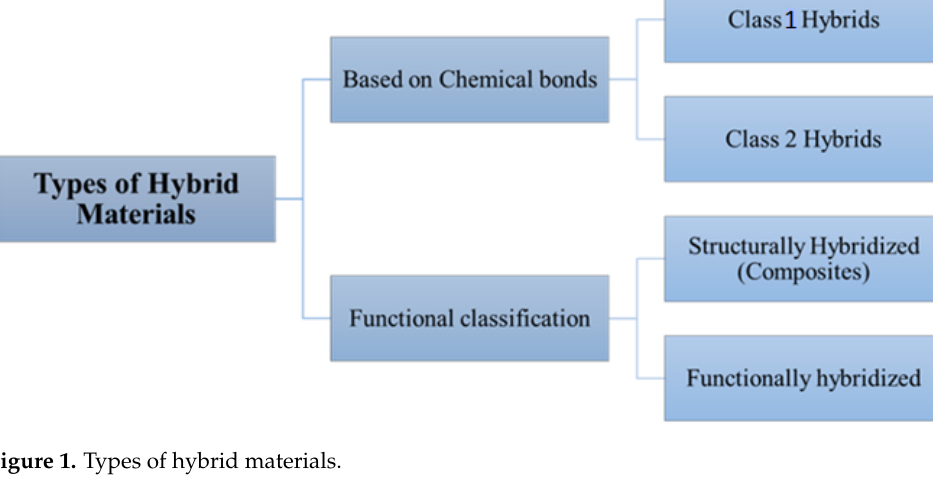
Figure 1. Types of hybrid materials.